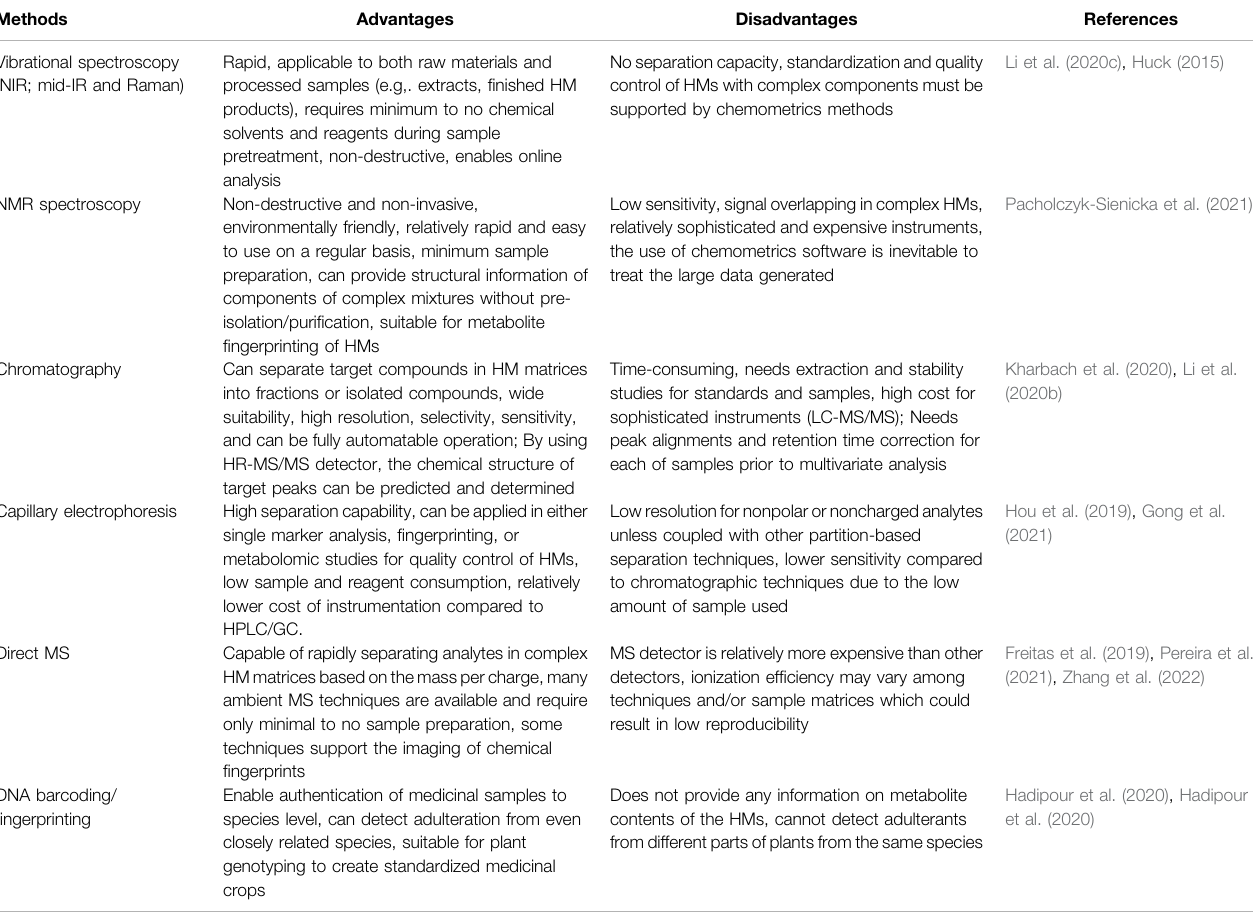
TABLE 1 | Advantages and disadvantages of fi ngerprinting methods for the standardization and quality control of herbal